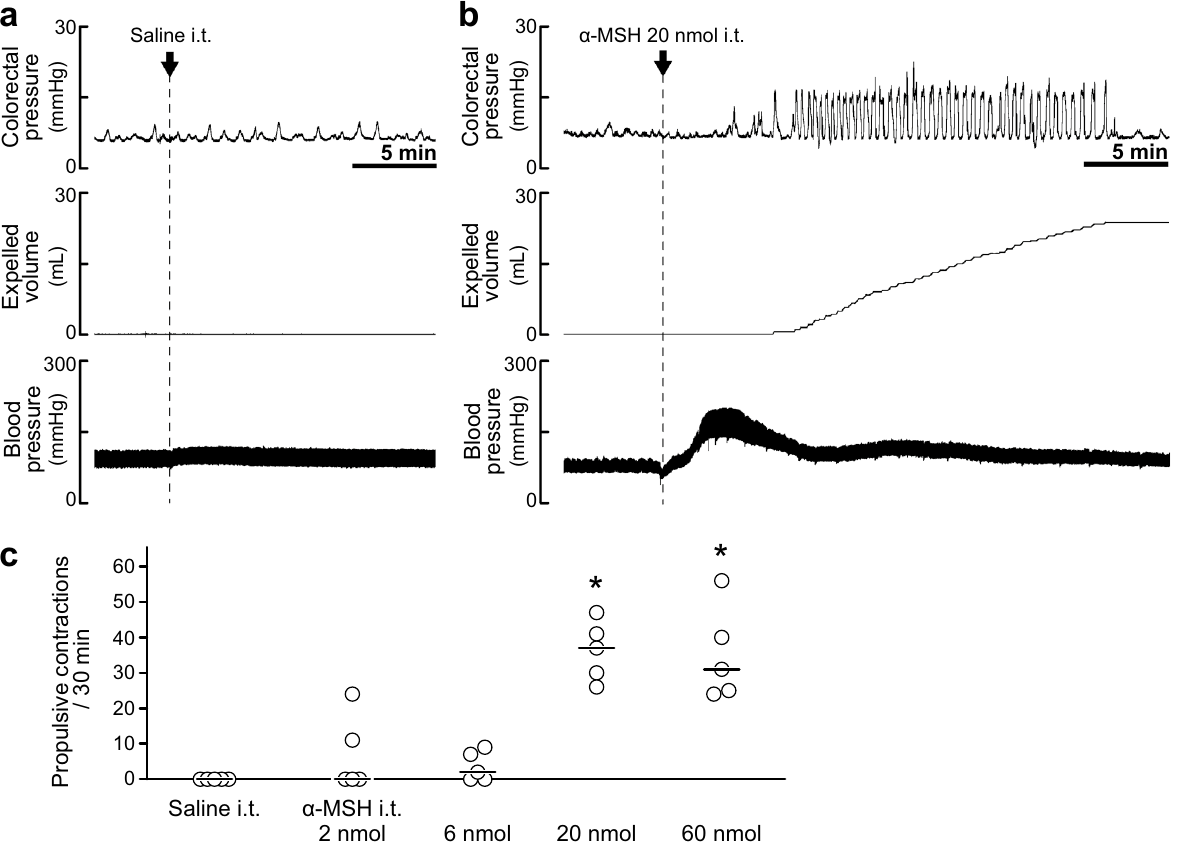
Saline i.t. Figure 1. Effects of intrathecal administration of α-MSH at the L6-S1 spinal cord. ( a , b ) Typical traces of colorectal pressure (upper), expelled volume (middle) and blood pressure (lower) before and after intrathecal administration (i.t.) of saline ( a ) or α-MSH (20 nmol) ( b ). Although saline had no effect on colorectal motility, α-MSH caused propulsive contractions (transient rises of colorectal pressure accompanied by an increase of expelled volume). ( c ) Summarised graph of number of propulsive contractions during a period of 30 min after saline i.t. or α-MSH i.t. (2, 6, 20 or 60 nmol). Higher doses of α-MSH (20, 60 nmol) significantly increased the number of propulsive contractions compared to that in the saline group. Each open circle ( ○ ) indicates a result from an individual rat, and the black bar shows the median. Five rats were used in each group. *Denotes a significant difference from the saline group ( P <